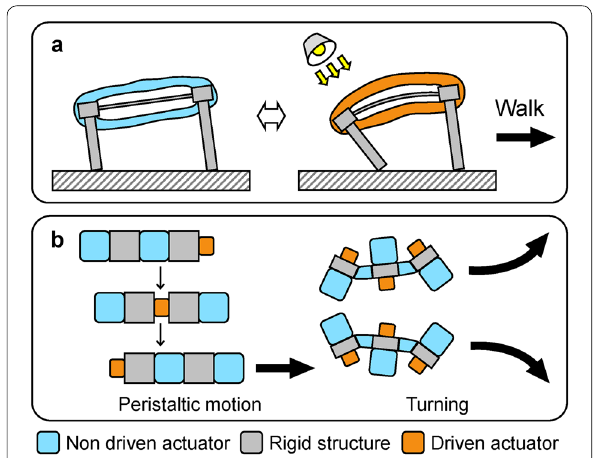
Fig. 1 Motion of soft microrobot. a Motion with actuation of single soft actuator, and b independent actuation of multiple soft